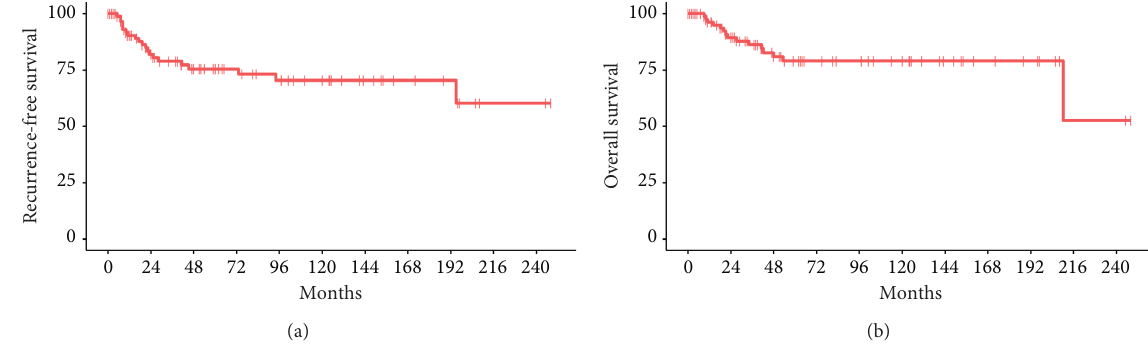
Figure 2: Kaplan–Meier curves of (a) recurrence-free survival and (b) overall survival for the entire cohort of 94 patients with localized Ewing sarcoma.